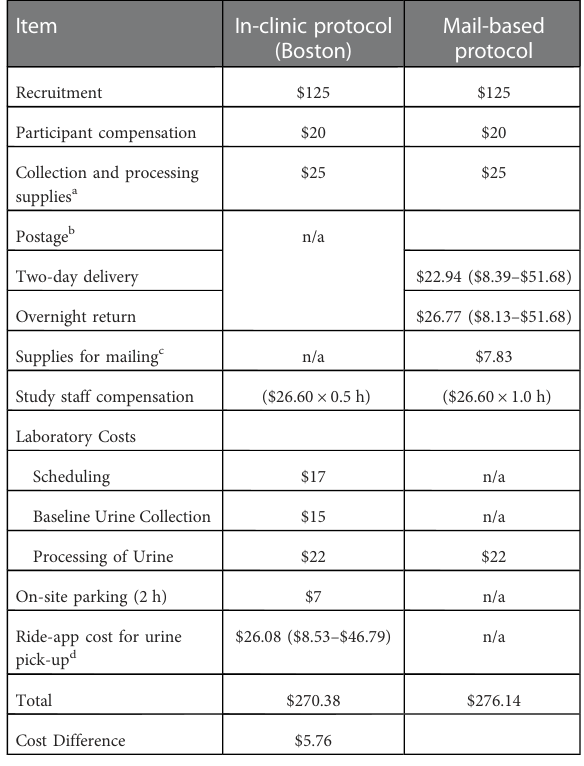
TABLE 2 Cost analysis for in-clinic and mail-based urine collection.